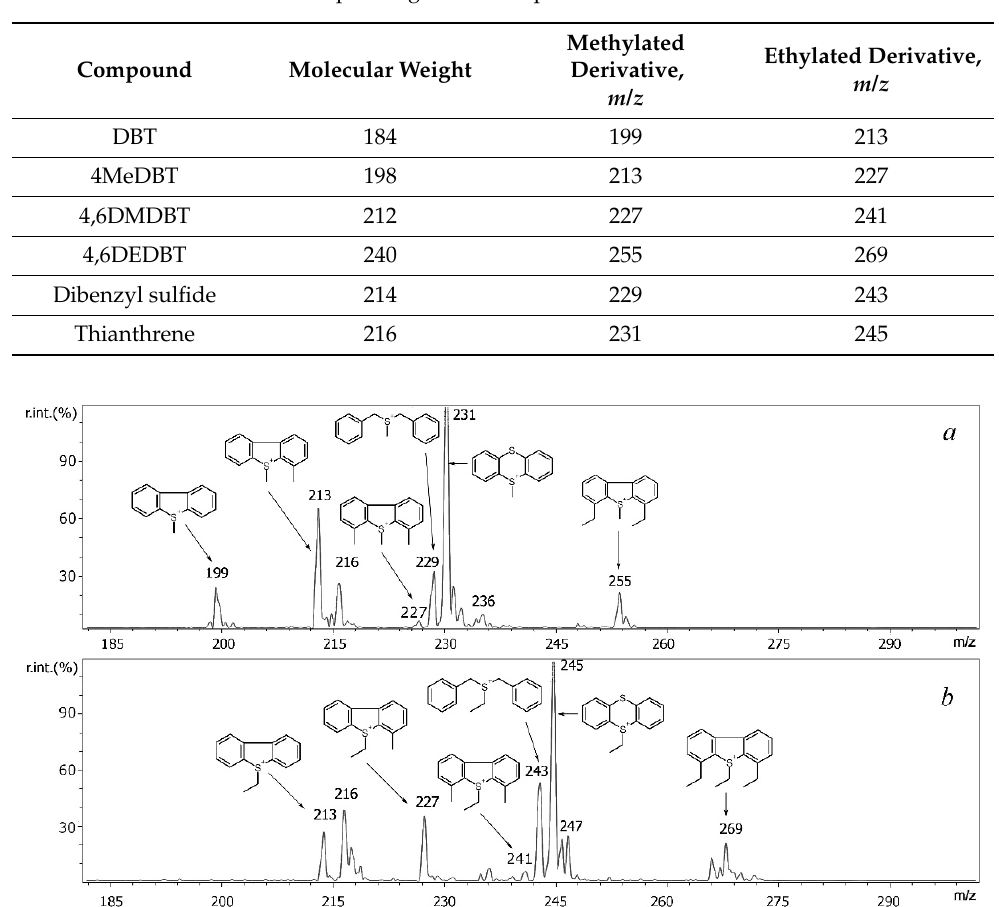
Table 1. The detected ions corresponding to cationic parts of the derivatives.